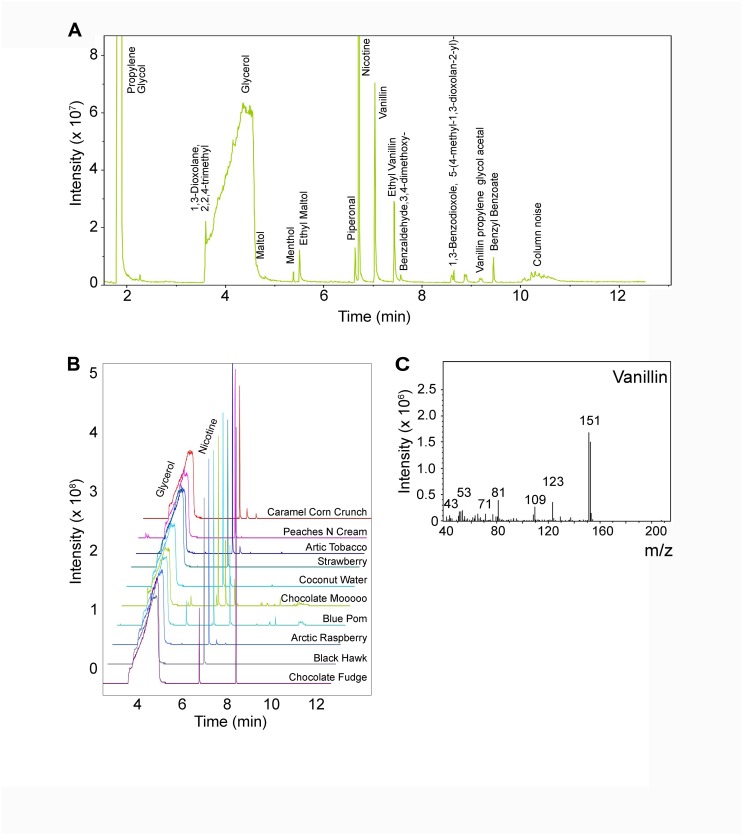
Analysis of e-liquids and their constituents by GC-MS and electron ionization.(A) Annotated chromatogram of “Dulce de Leche” e-liquid analyzed by GC-MS. PG and nicotine peaks appear off-scale to improve visibility of flavorings and additives. (B) Stacked chromatograms of 10 representative e-liquids analyzed by GC-MS. Glycerol and nicotine peaks are also shown, and PG is excluded for improved visibility of low-abundance compounds. (C) Representative electron ionization mass spectra of vanillin. GC-MS, gas chromatography–mass spectrometry; PG, propylene gycol.